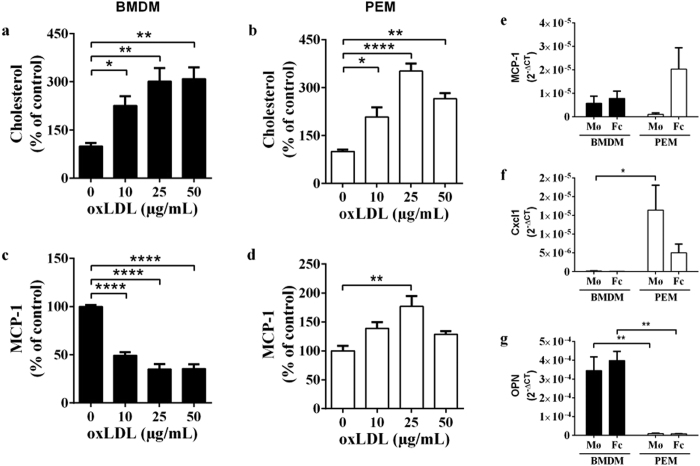
BMDMs and PEMs have a different inflammatory response to oxLDL stimulation.(a–d) Cholesterol or MCP-1 content (% of control (0 μg/mL oxLDL)) in BMDMs (a,c) and PEMs (b,d) after stimulation with 0–50 μg/mL oxLDL for 24 hours (each graph represents 3 separate experiments (n = 3–4 wells per experiment)). *p < 0.05, **p < 0.01, ****p < 0.0001, as determined by 1-way ANOVA with Dunnets post-test. Each graph represents one representative experiment (triplicate analyses of BMDMs from one mouse or PEMs from a pool 4–5 of mice). Experiments were triplicated with similar results (i.e. n = 3 mice for BMDMs and 3 pools of 4–5 mice for PEMs). (e–g) mRNA expression (2−ΔCT) of monocyte chemoattractant protein 1 (MCP-1) (e), chemokine (C-X-C motif) ligand 1 (Cxcl 1) (f) or osteopontin (OPN) (g) in BMDMs or PEMs after incubation with 0 μg/mL oxLDL (macrophage, Mø) or 25 μg/mL oxLDL (foam cells, Fc) for 24 hours (n = 3 mice for BMDMs; n = 3 pools of mice for PEMs). *p < 0.5, **p < 0.01, as determined by 2-way ANOVA.